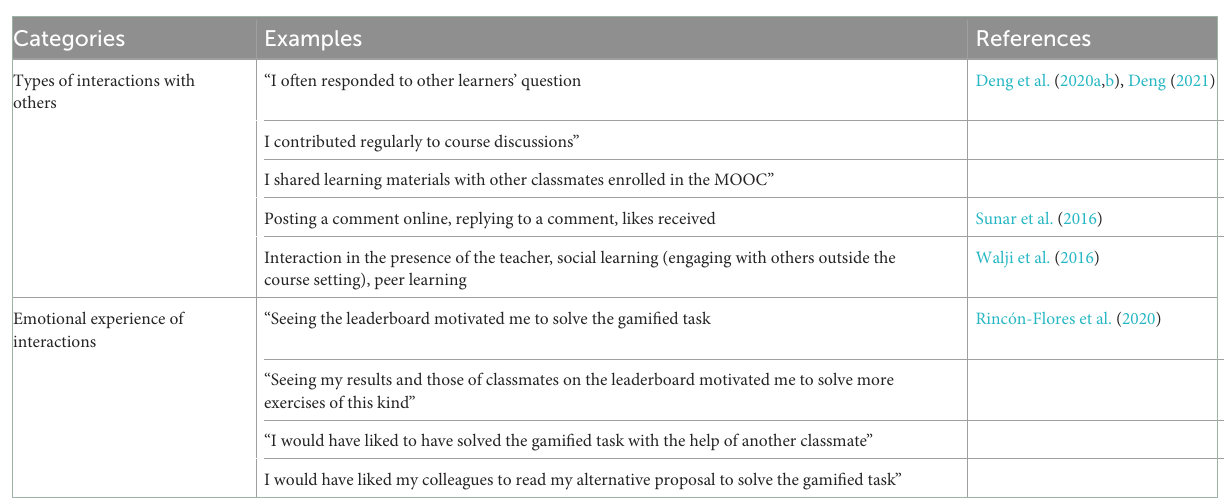
TABLE 6 Categories of social